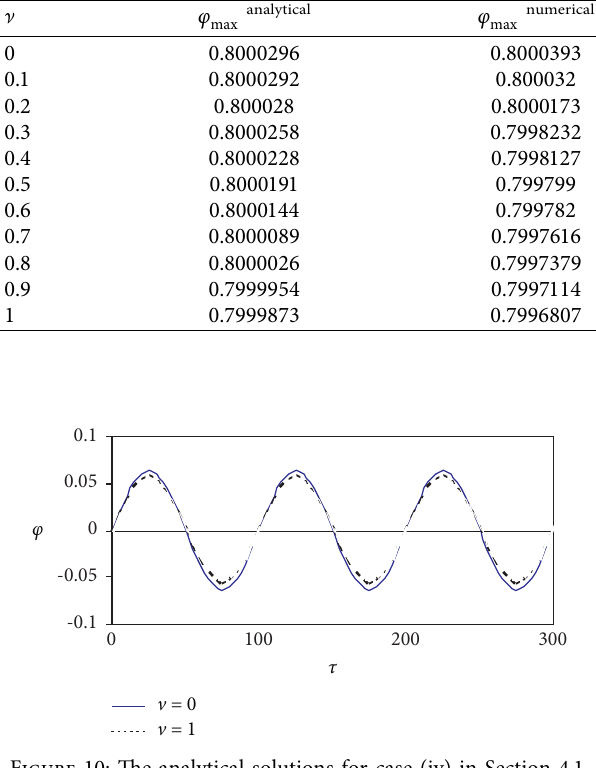
Figure 10: The analytical solutions for case (iv) in Section 4.1.